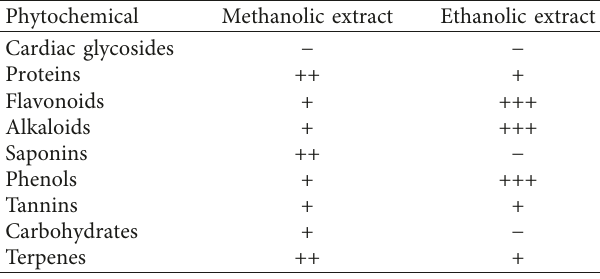
Table 1: Secondary metabolites in methanolic and ethanolic ex- tracts of C. quadrangularis leaves.